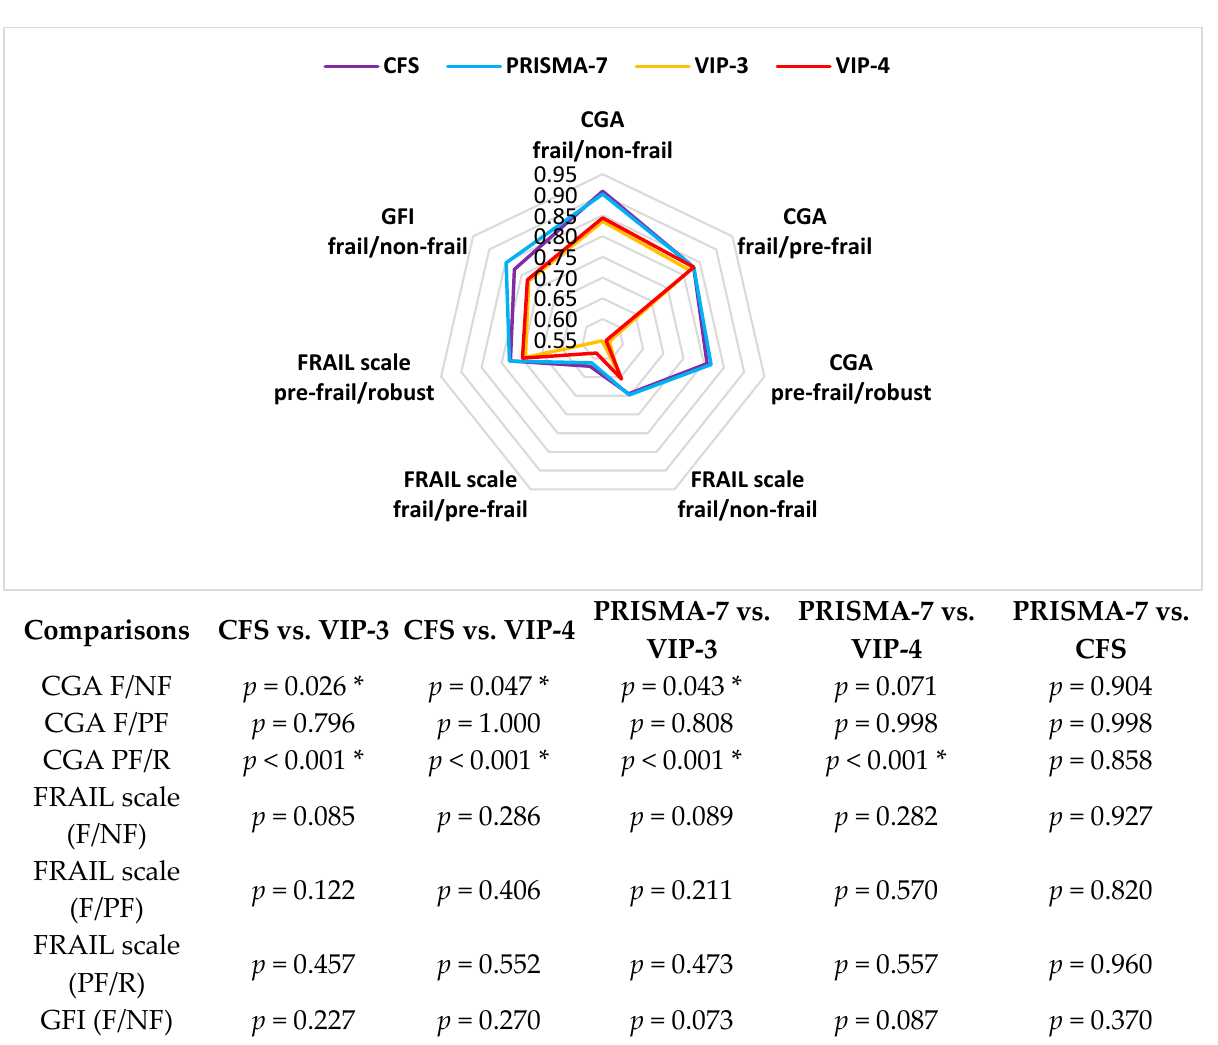
Figure 2. Comparison of area under the curve scores between the Clinical Frailty Scale (CFS), the Programme of Research to Integrate Services for the Maintenance of Autonomy 7 (PRISMA-7) tool, the three-item Variable Indicative of Placement risk (VIP-3) and the four-item Variable Indicative of Placement risk (VIP-4) for differentiating participants who were frail from non-frail (F/NF), frail from pre-frail (F/PF), and pre-frail from robust (PF/R), with p -values illustrating the statistical significance of differences between the AUC of each tool. * Significance tests ( p < 0.05). Table 4. Diagnostic and predictive accuracy for different outcomes based on area under the curve (AUC) scores for the Clinical Frailty Scale (CFS), the Programme of Research to Integrate Services for the Maintenance of Autonomy 7 (PRISMA-7) tool, the Variable Indicative of Placement risk, three item (VIP-3) and four-item (VIP-4) versions.